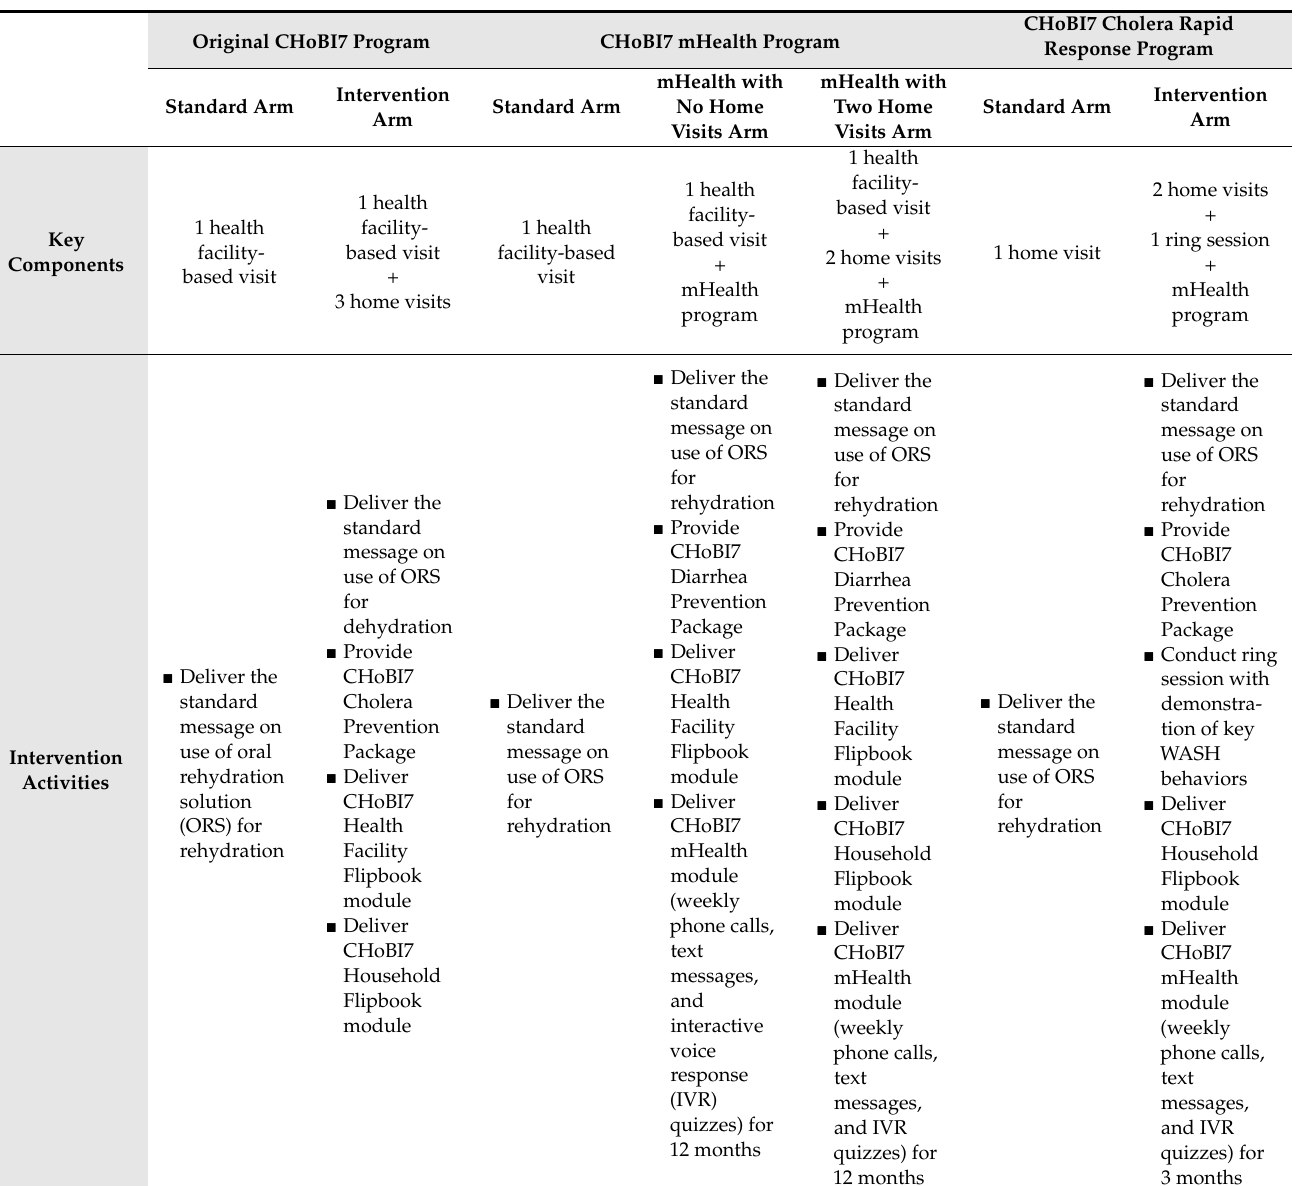
Table 2. Overview of CHoBI7 program